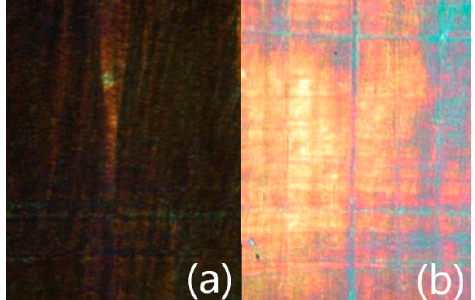
Figure 4. Microphotographs of textures obtained by POM in the SmC* phase (at 75.0 °C) of the PE-FLC nanocomposite film (17 µm thick) after alignment by the a.c. electric field of low frequency (10–20 Hz, 40 kV cm − 1 applied for 5–30 min.): ( a ) the angle between the polarizer plane and main direction of porous long axes is 45° (dark state) and ( b ) the angle between the polarizer plane and main direction of porous long axes is 0° (bright state). Width of each sub-microphotograph is ~250 µm.